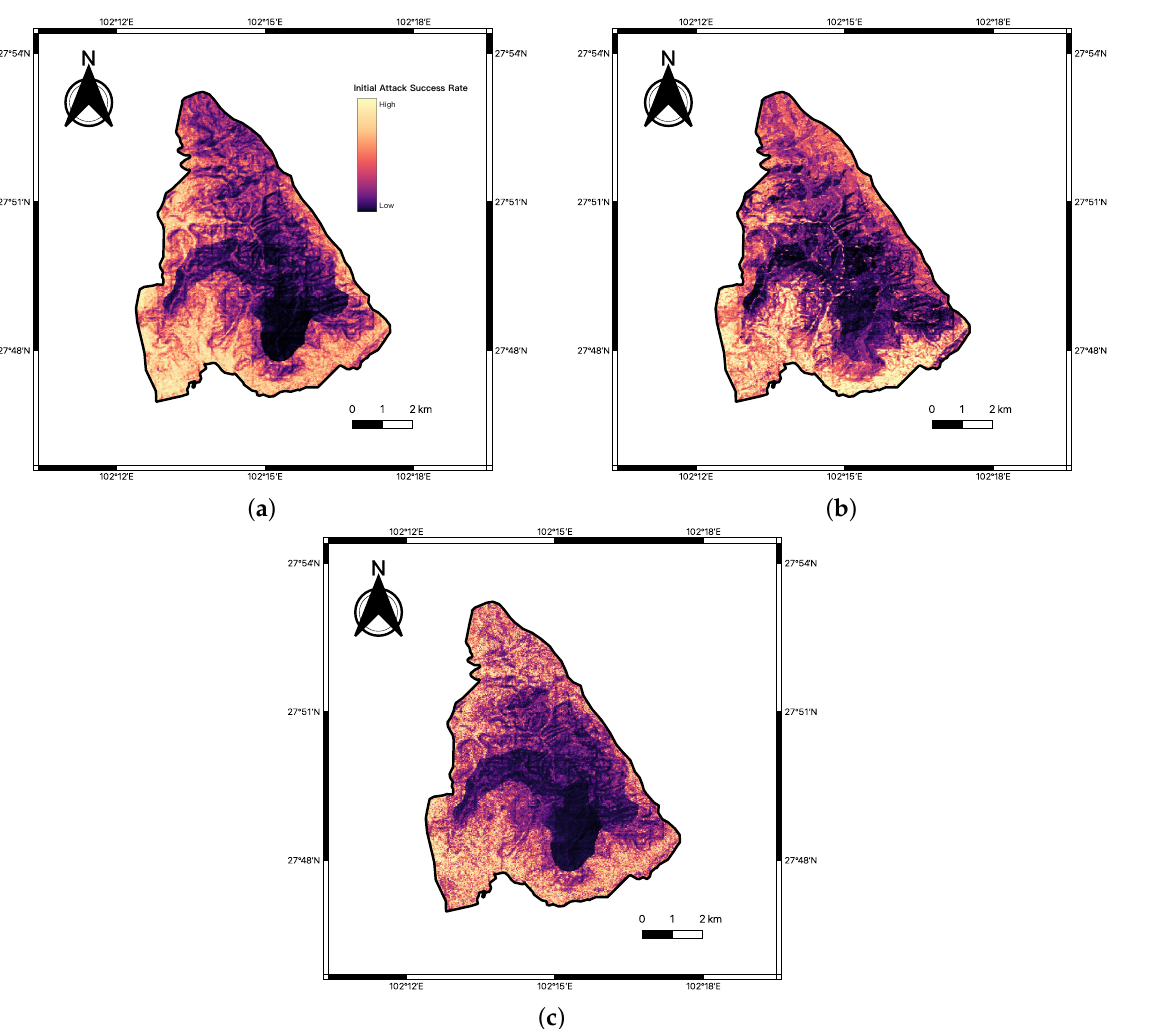
Figure 9. Simulated Initial Attack Results Under Extreme Weather; ( a ) Logistic Regression; ( b ) XGBoost; ( c ) Artificial Neural Network.